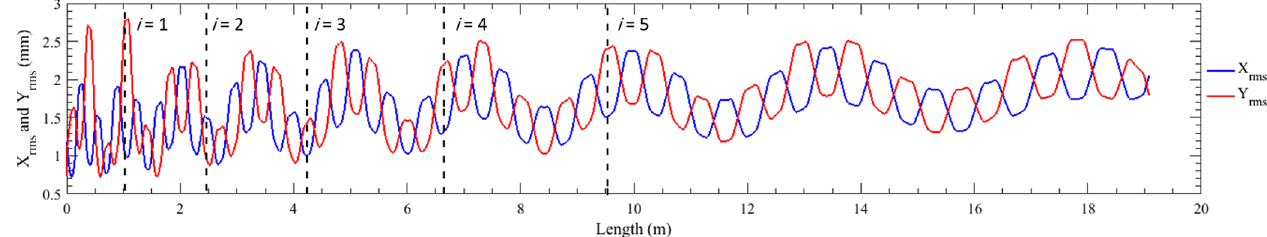
FIG. 6. Beam envelope propagation along the DTL for unmatched Twiss parameters.